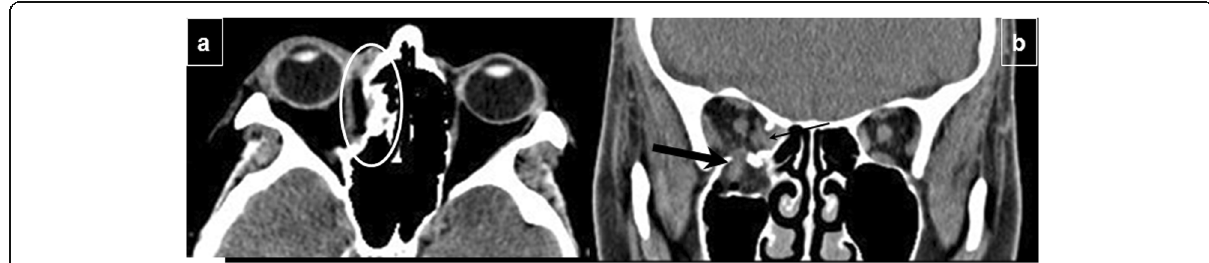
Fig. 13 Orbital blowout. a Axial CT image shows disruption of the internal wall of the orbit with fat herniation (circled). b Coronal view shows internal (thin arrow) and inferior (thick arrow) wall disruption; the inferior rectus muscle has herniated and has consequently lost its normal flattened appearance